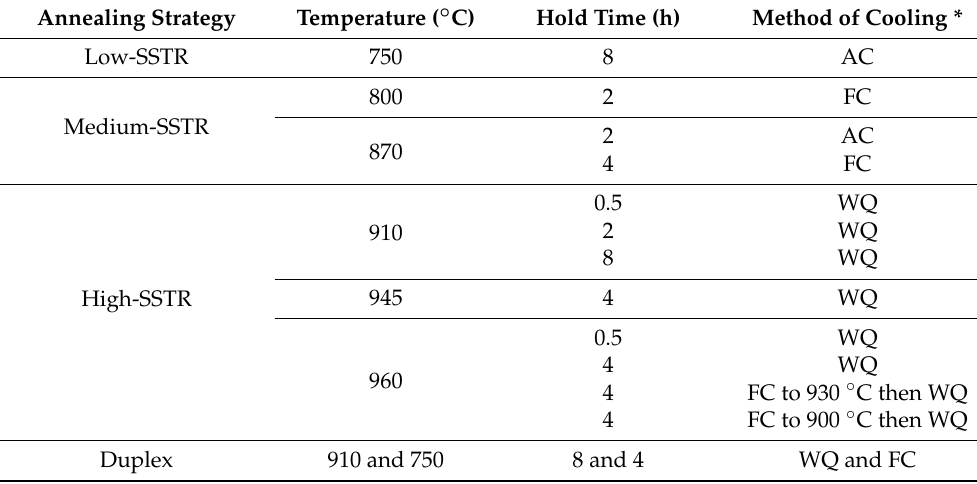
Table 3. Specifications for heat treatment strategies.